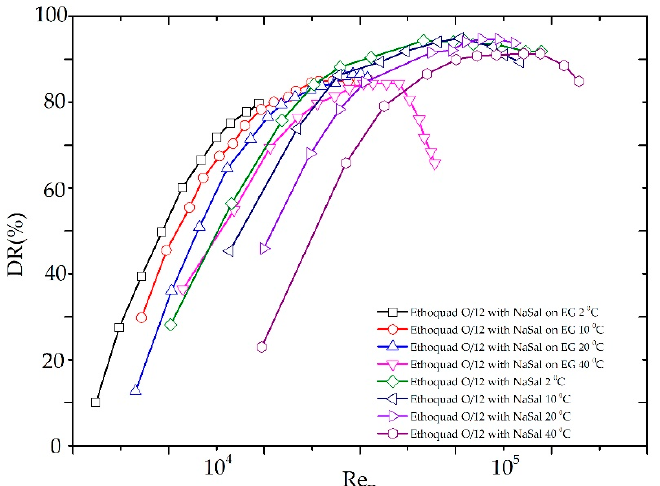
Figure 6. Drag reduction effect of Ethoquad O/12 with NaSal (sodium salicylate) in water and drag reduction effect of Ethoquad O/12 with NaSal on EG (ethylene glycol) with water at different tem- peratures.